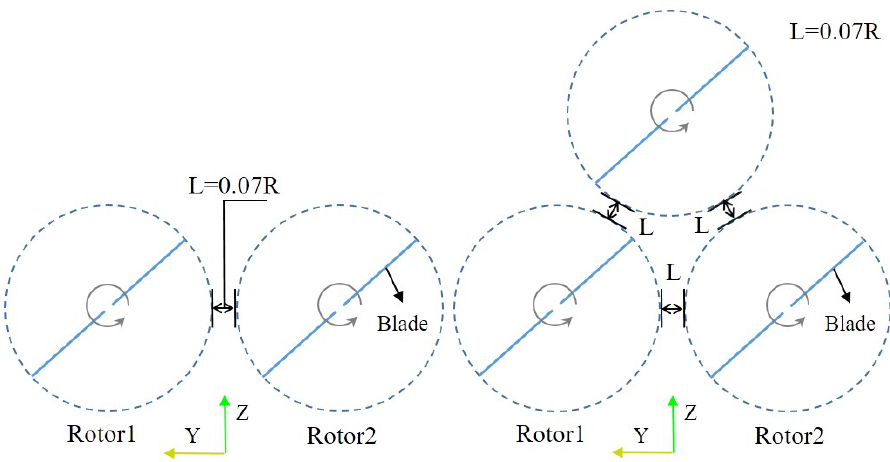
Figure 2. Layout diagram of co-planar twin- and tri-rotor wind turbine